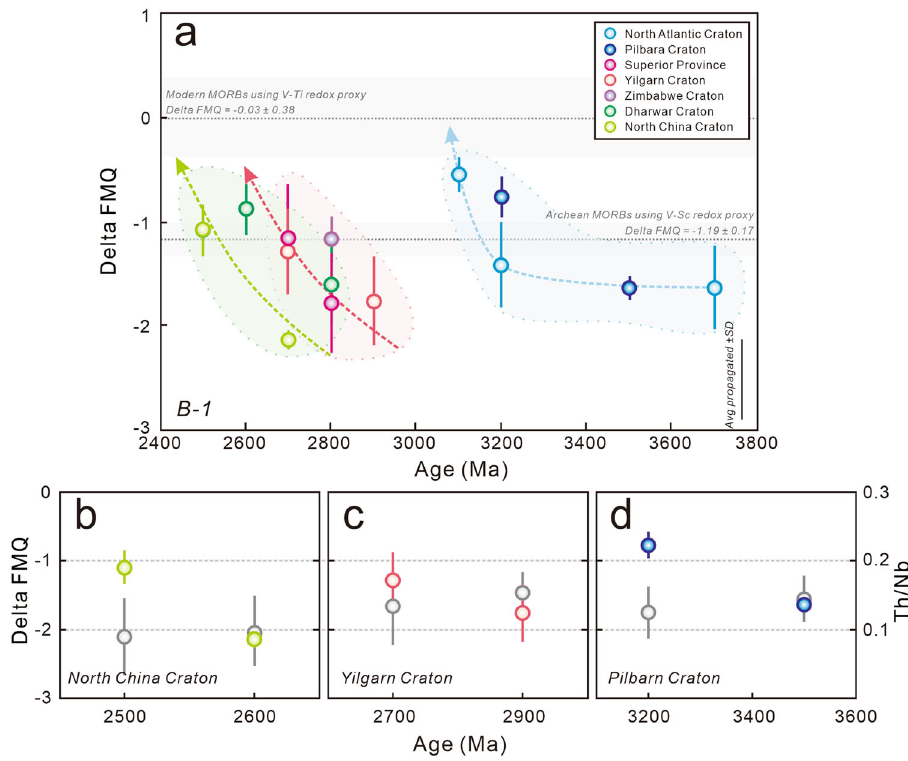
Fig. 1 Redox state of Archean Basalt-1 (B-1) samples calibrated by the updated V-Ti redox proxy. a The f O 2 estimations of B-1 samples. The f O 2 values and respective uncertainties (grey intervals) of Archean mid-ocean ridge basalt (MORB)-like samples estimated by V-Sc redox proxy and modern MORBs by V-Ti redox proxy were used for comparison 1,8,14 . The uncertainties in the bottom right corner represent the average 1 standard deviation (SD) propagation of B-1 samples. b – d The time evolution of f O 2 estimations and Th/Nb ratios in the North China, Yilgarn and Pilbara cratons, respectively. The grey symbols are the corresponding Th/Nb ratios of B-1 samples. Error bars show the 1 SD of the